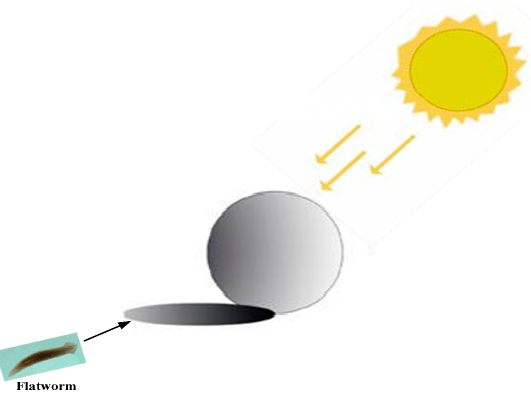
Figure 1. The flatworm moves toward the dark region.